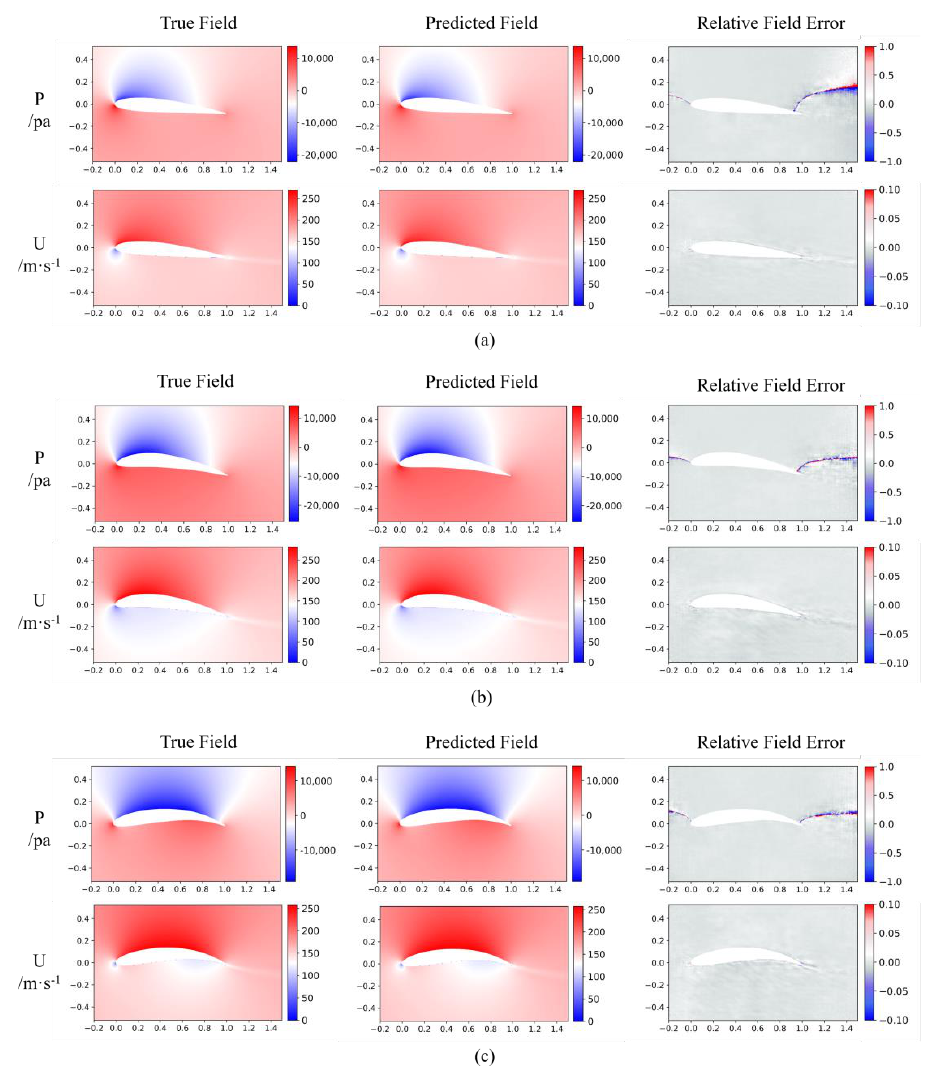
Figure 10. The true (CFD) and predicted physical fields for three airfoils under Re = 5 × 10 6 : ( a ) NACA2412 with 5 ◦ AOA; ( b ) NACA7412 with 6 ◦ AOA; ( c ) NACA9612 with 1 ◦ AOA.